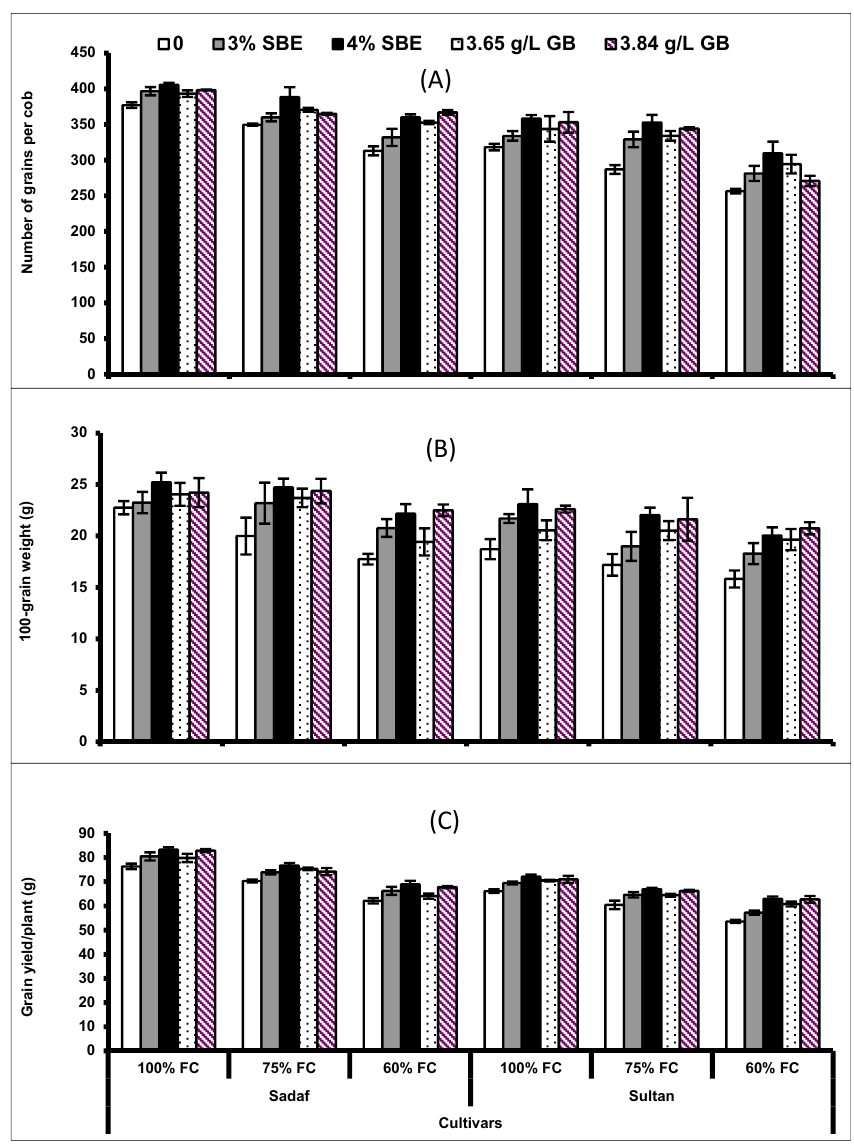
Figure 7. ( A ) Number of grains, ( B ) 100-grain weight and ( C ) grain yield of two maize cultivars foliar-fed with varying levels of sugar beet extract (SBE) and glycine betaine under water deficit conditions (Mean ± S.E.).